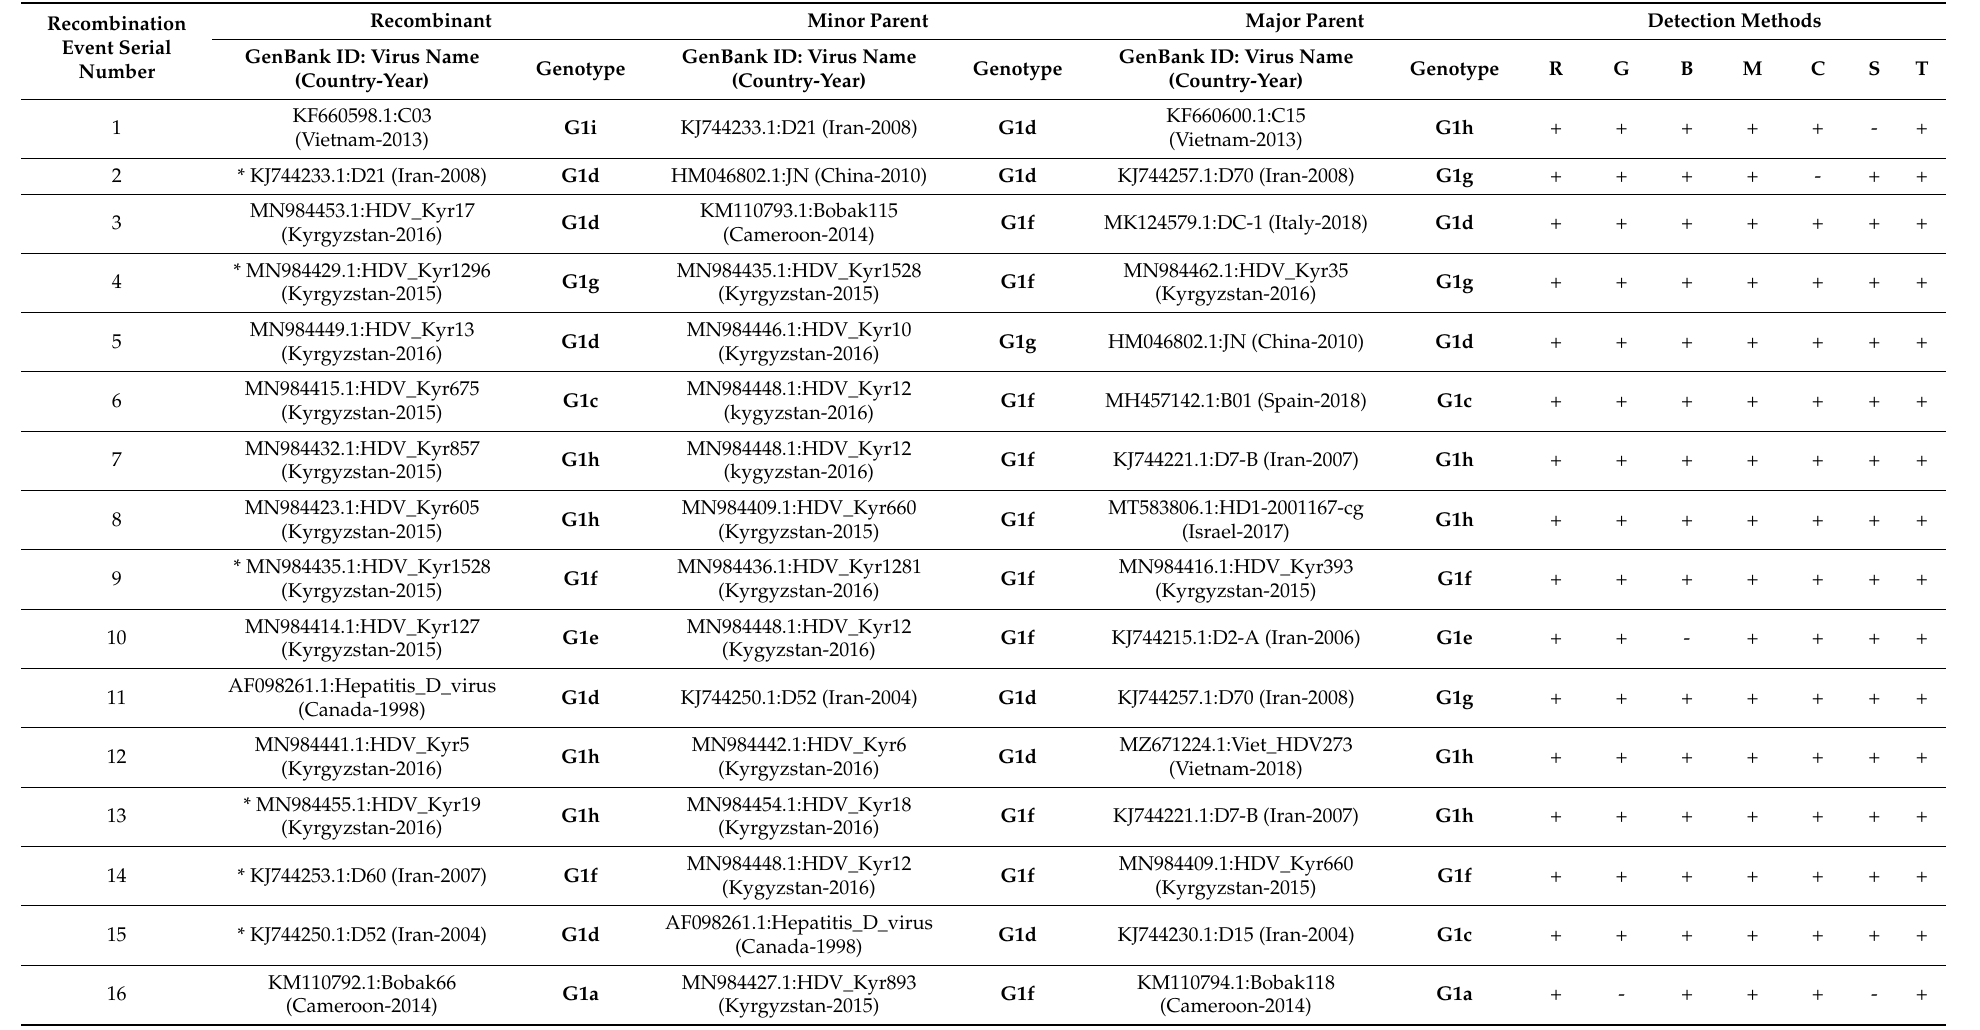
Table 2. The potential recombination events in the genome of HDVs. R, RDP; G, GENECONV; B, BootScan; M, MaxChi; C, Chimaera; S, SiScan; T, 3seq. +, verified; -, not verified. * The major or minor parent may be the actual recombinant due to the possibility of